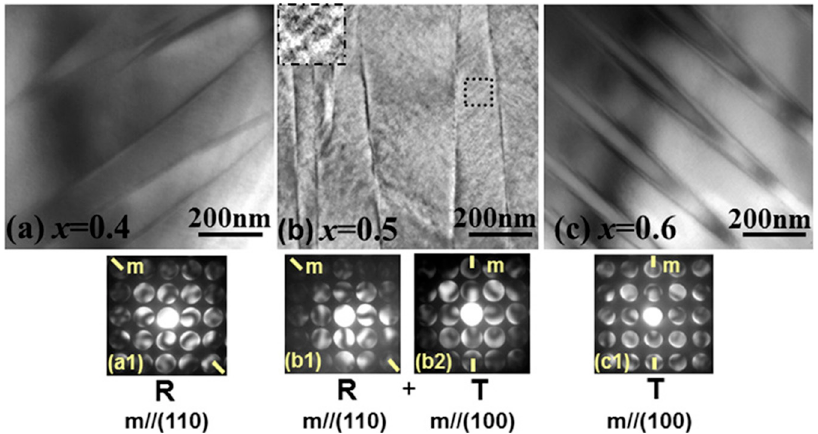
Figure 13. Transmission electron microscopy (TEM) images of different compositions of (1 − x )BZT– x BCT. ( a ) x = 0.4; ( b ) x =0.5; ( c ) x = 0.6; ( a1 , b1 , b2 , c1 ) the convergent beam electron diffraction pattern obtained from one grain [69].